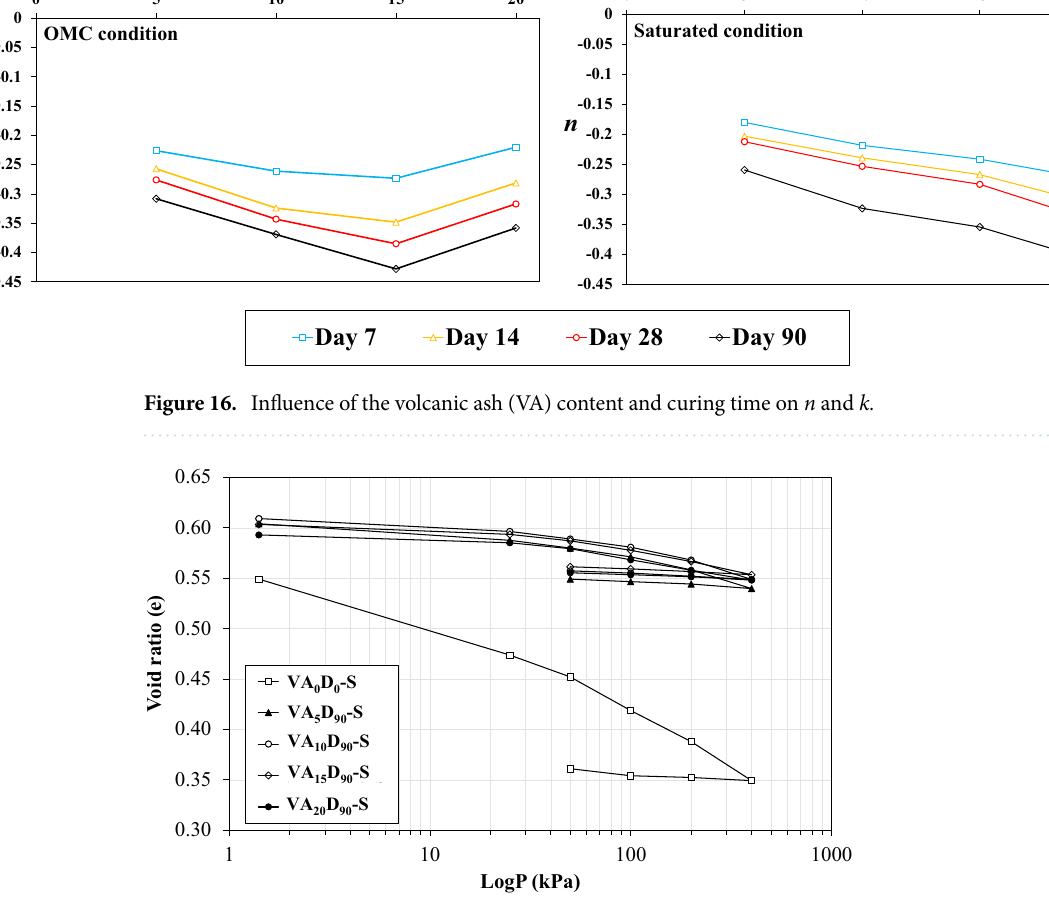
Figure 17. Consolidation curve for different volcanic ash (VA) contents at 90 days of curing